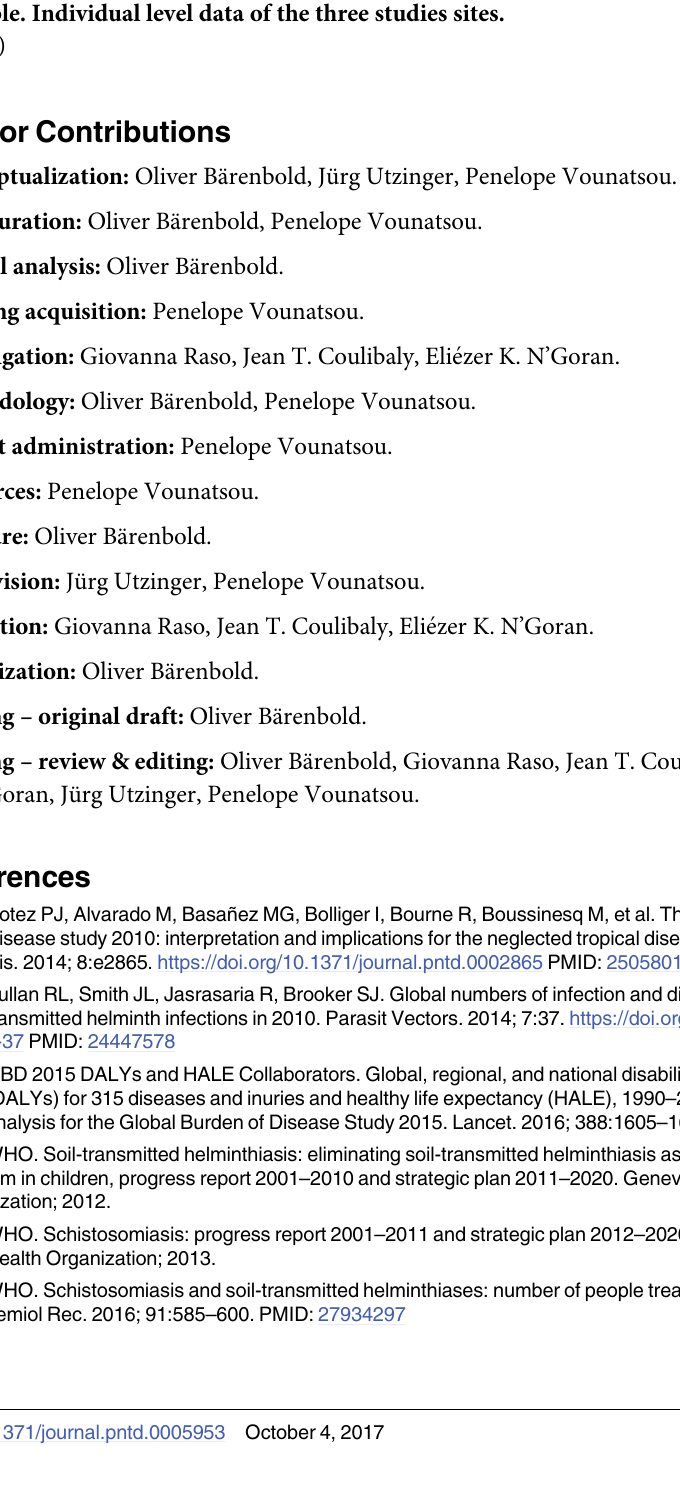
S1 Table. Individual level data of the three studies